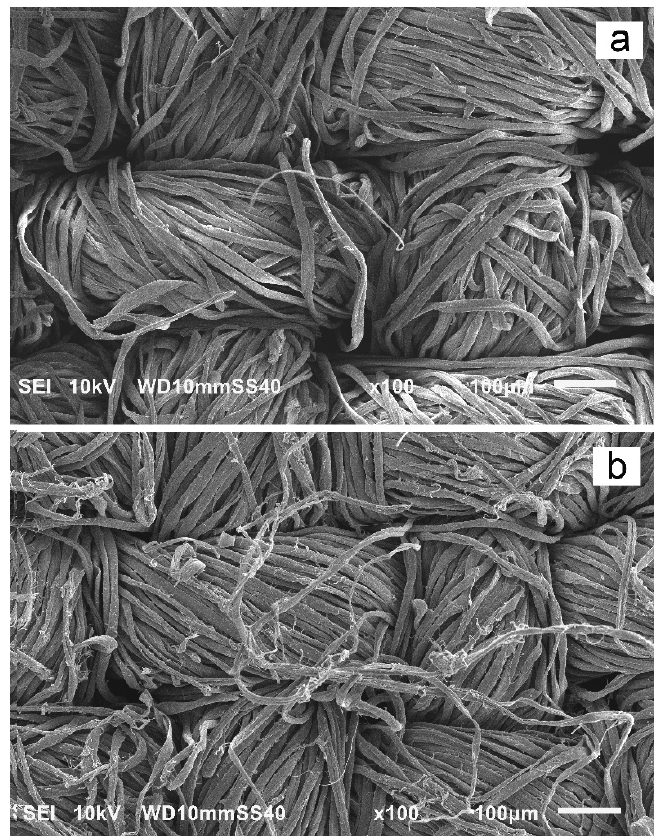
Figure 5. SEM micrographs of cotton fabric samples: ( a ) untreated (P0), and ( b ) disinfected and washed 120 times (P120).